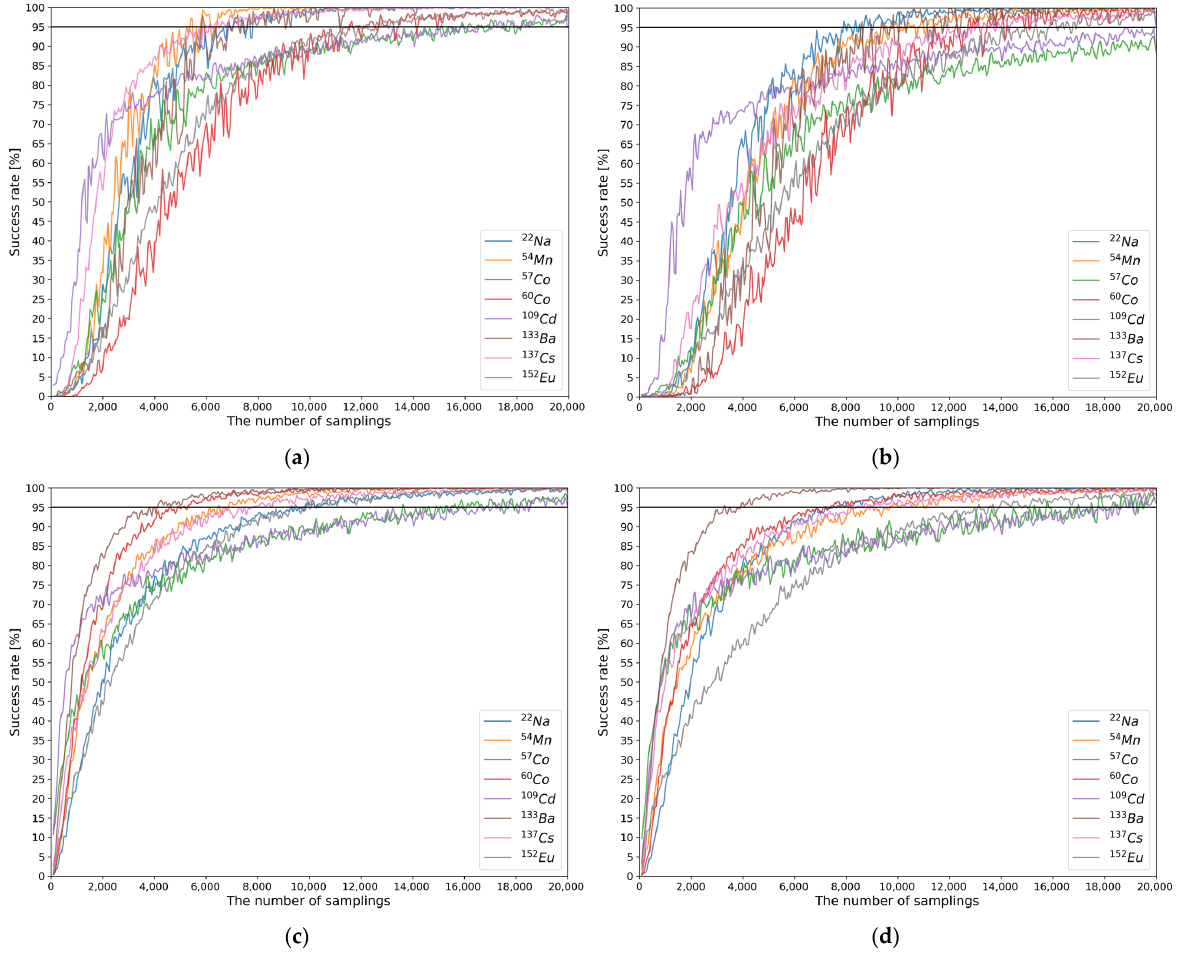
Figure 8. Success rates with the evaluation sets for the generation and regression tasks performed by the baseline model and our final MTL model. ( a , b ) Plots of the success rates in the generation and regression tasks, respectively, for the baseline model; and ( c , d ) plots of the success rates in the generation and regression tasks, respectively, for our final MTL model.